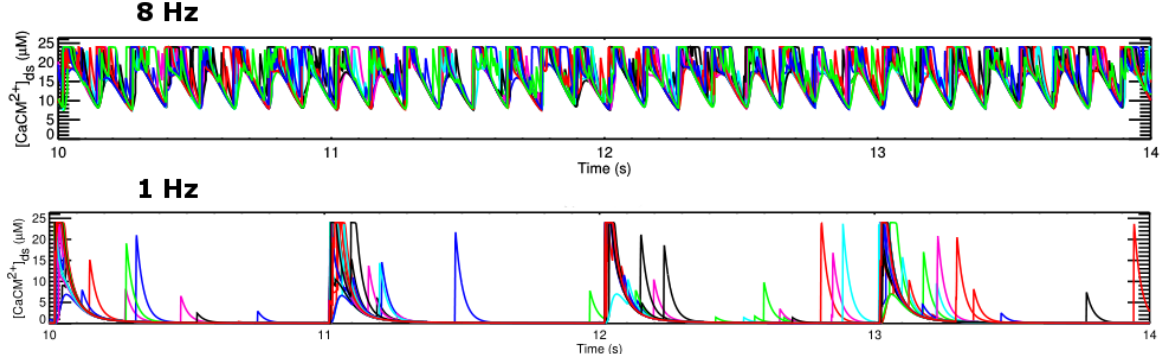
Figure A3. The amount of Ca 2+ /CaM complex in the subspace is greater during pacing at 8 Hz compared to acing at 1 Hz pacing leading to increased Ca-dependent inactivation of the L-type channel.